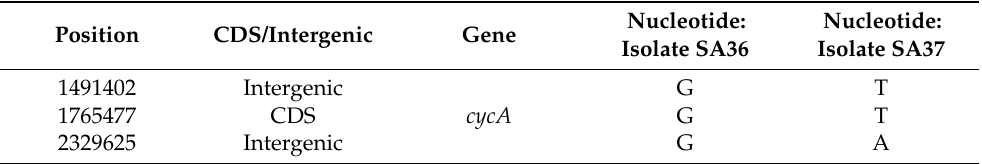
Nucleotide: Isolate SA36